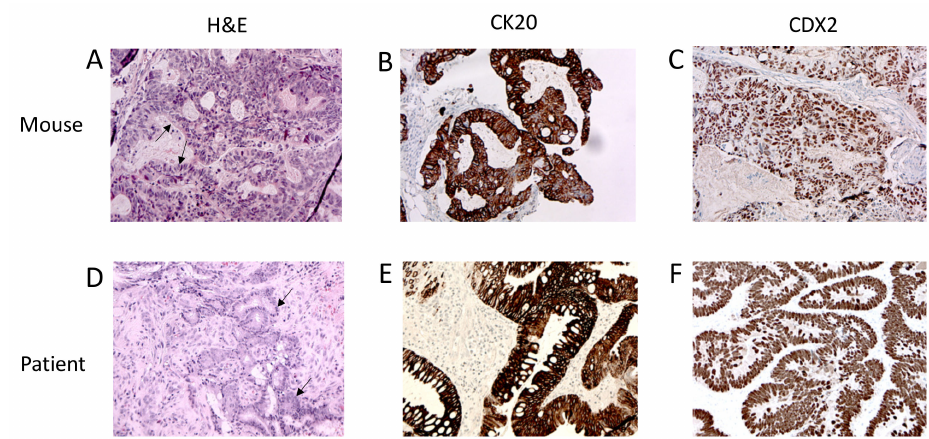
Figure 1. Animal model-derived tumors presented the same phenotype as human parental cancer. ( A ) Hematoxylin and Eosin (H&E) staining, ( B ) CK20 and ( C ) CDX2 immunohistochemistry of the mouse xenograft. ( D ) Hematoxylin and Eosin staining, ( E ) CK20 and ( F ) CDX2 immunohistochemistry of human colorectal cancer biopsy. Arrows indicate the gland structures. Magnification 20 ×